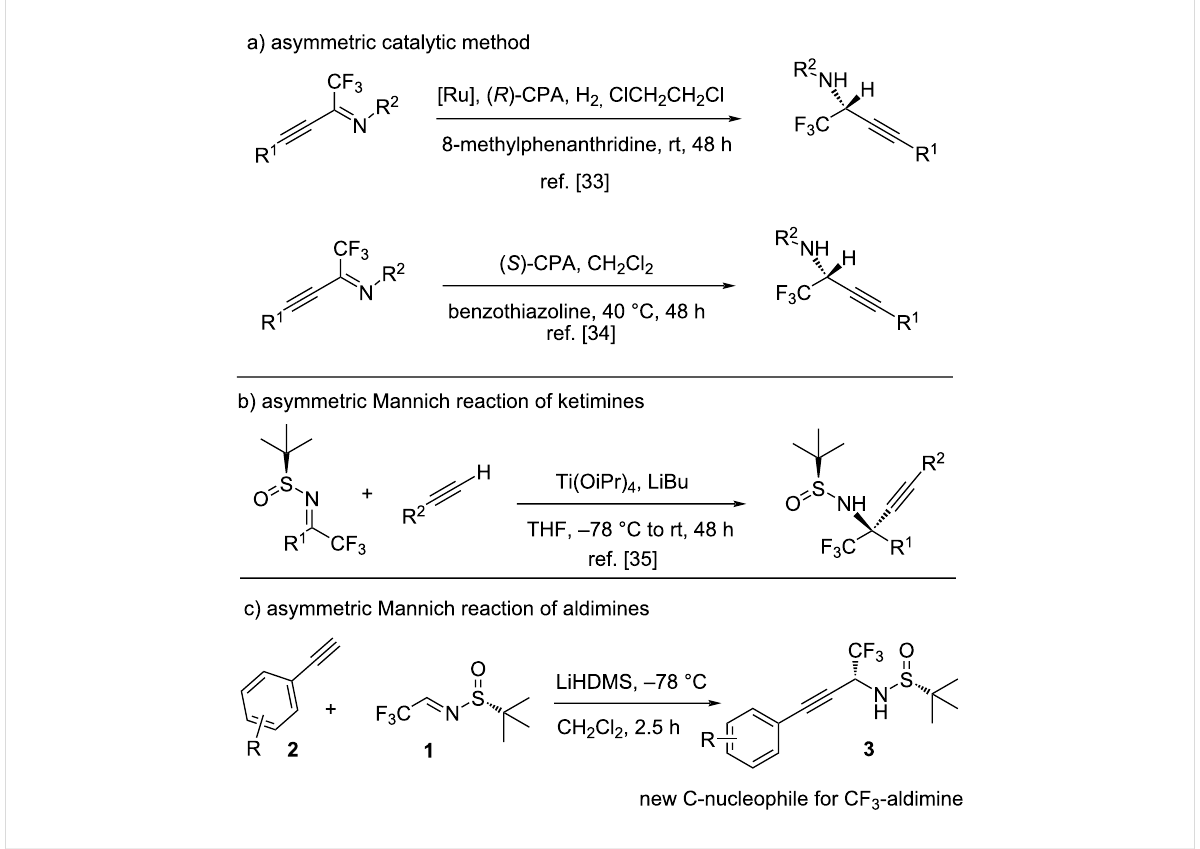
Thus, the development of synthetic methods for the